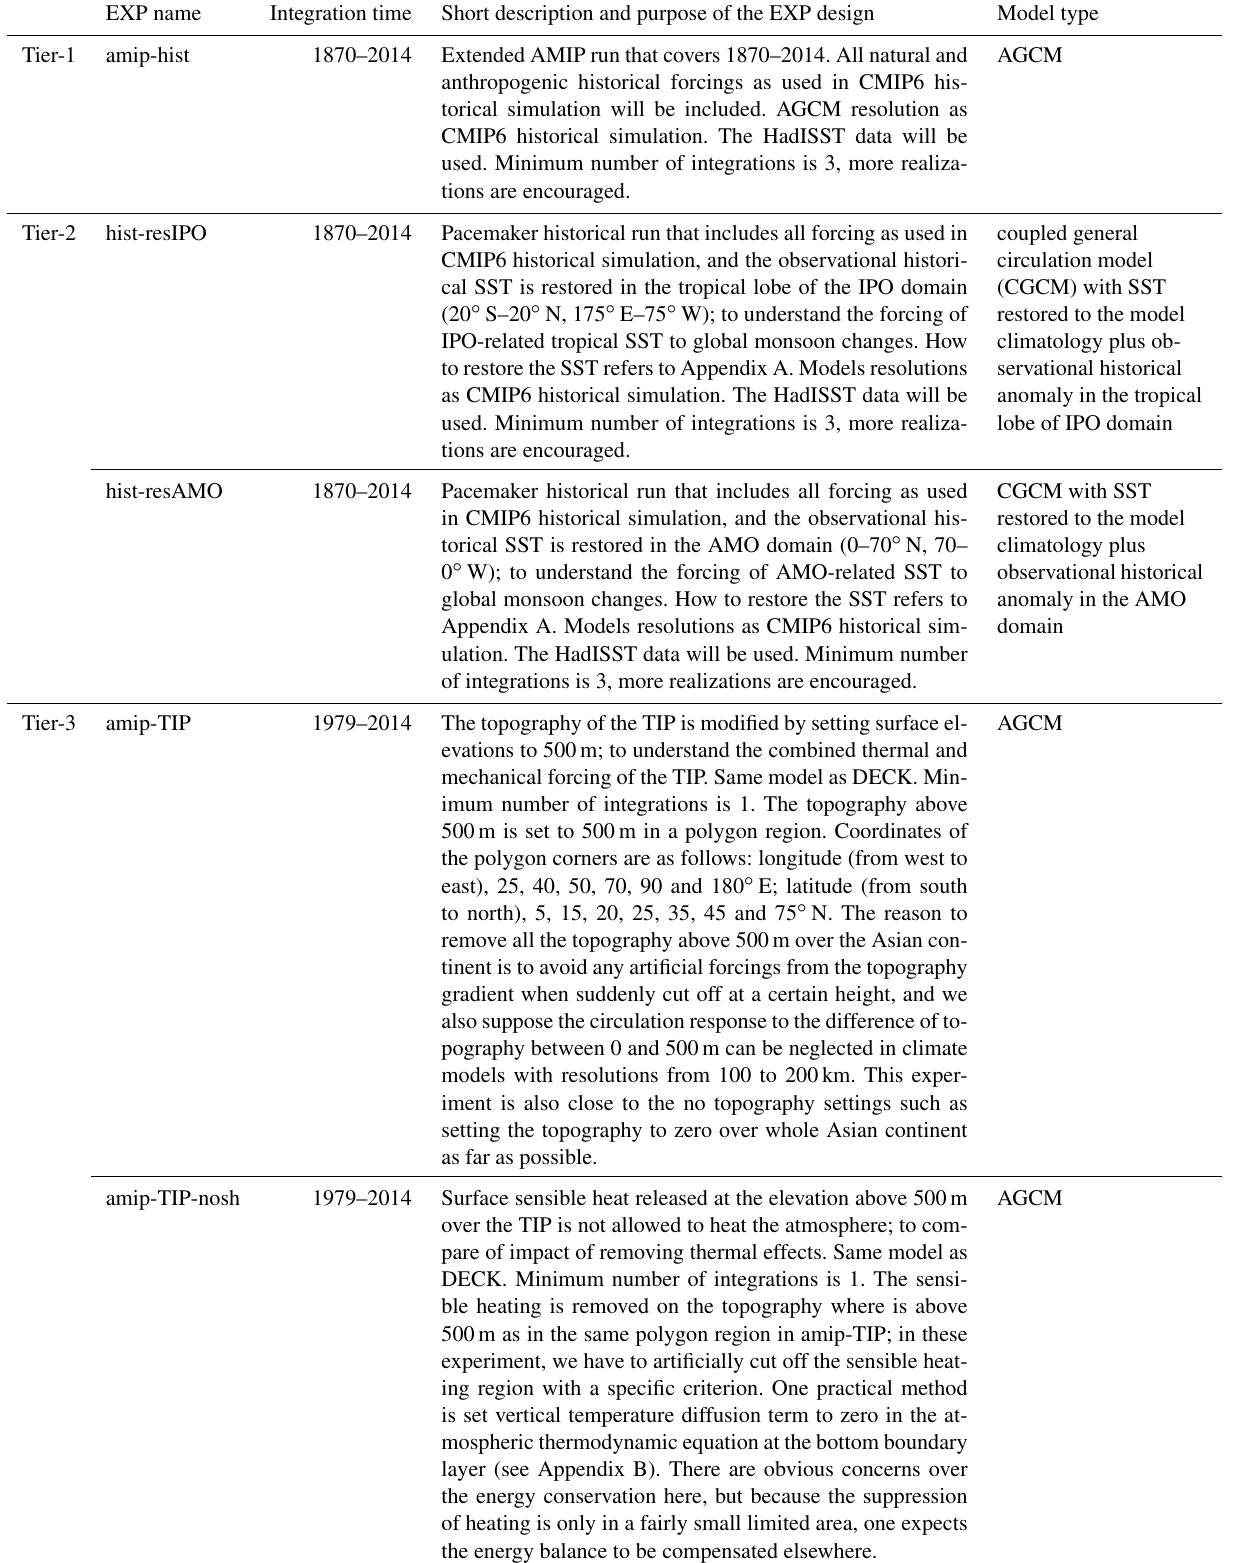
Table 2. Experiment list of